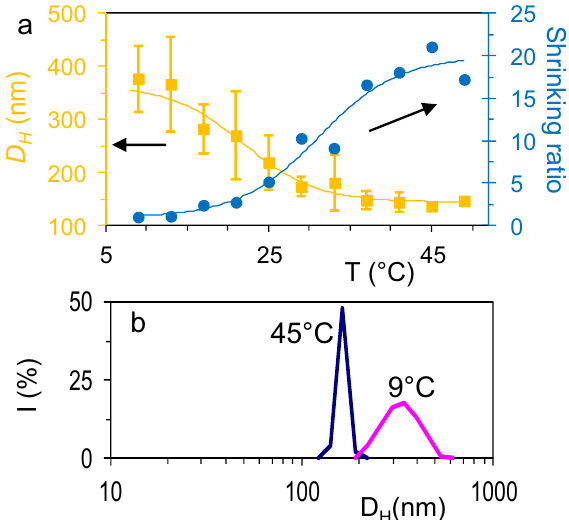
Figure 3. ( a ) Temperature dependence of D H for hybrid Fe 3 O 4 @PMEO 2 MA microgels and the shrinking ratio (heating from 9 to 49 ºC), ( b ) DLS measurements based on the scattered intensity of the hybrid microgels measured at 9 °C and 45 °C. Errors bars indicate the standard deviation of three replicates each.